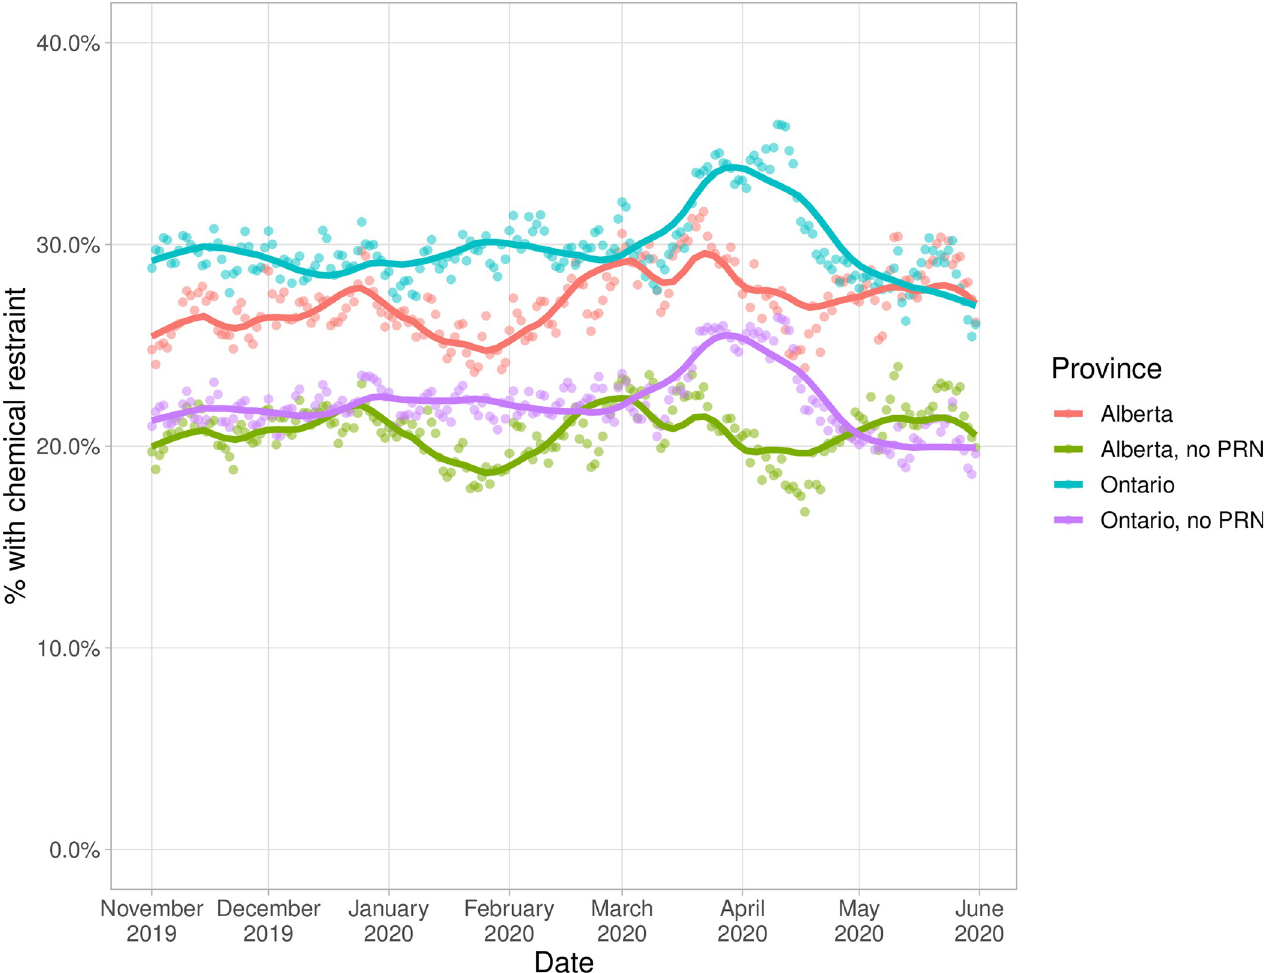
Fig 3. Proportion of older adults ( � 65) admitted to acute care hospitals who were ordered chemical restraints in Alberta and Ontario, November 2019 to May 2020, with and without as needed medications. Abbreviation: PRN =